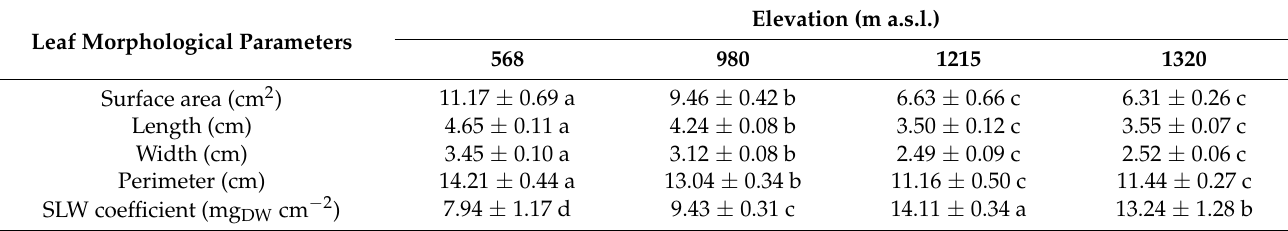
Table 1. Morphological parameters of the leaves of green alder ( Alnus viridis ) growing in the Bieszczady Mts. at various elevations a.s.l. Leaf Morphological Parameters